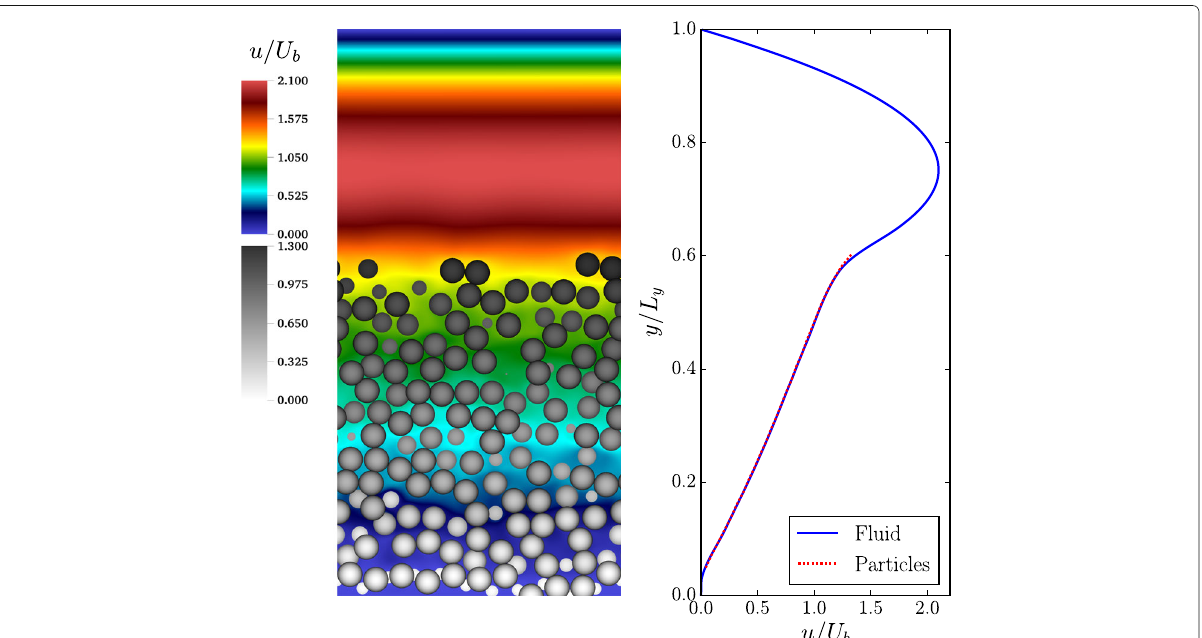
Fig. 4 Pressure-driven flow over a dense sediment bed. The left figure shows an instantaneous slice through the domain, the color scale illustrating streamwise fluid velocity, and the gray scale illustrating particle velocity. The right figure shows the time-and-space-averaged streamwise velocity of the fluid and particles